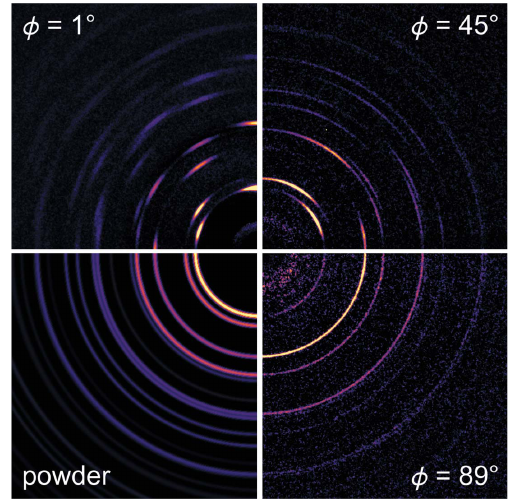
Figure 1 Sections of detector images of the textured Pt sample at different tilt angles (cid:3) , and a simulated perfect powder Pt detector image. The colorscale is in arbitrary